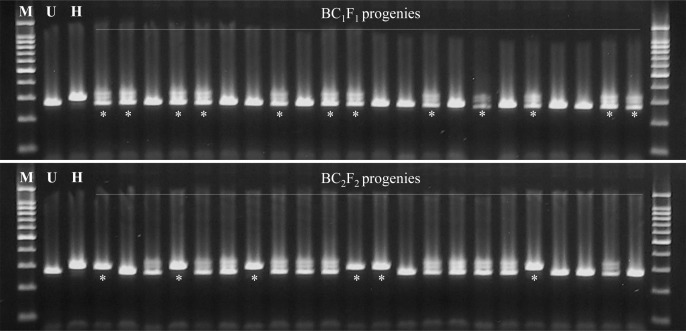
Foreground selection with gene specific marker InDel7 in BC1F1 and BC2F2.M: 100 bp ladder, U: recurrent parent Unkwang, H: donor parent Haedamssal, *: selected plants.